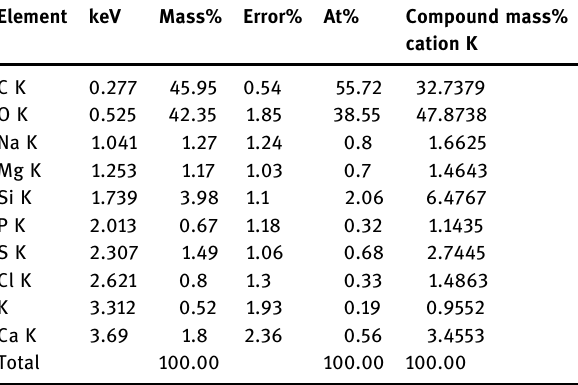
Table 8: EDS analysis of G. amansii biomass before adsorption of